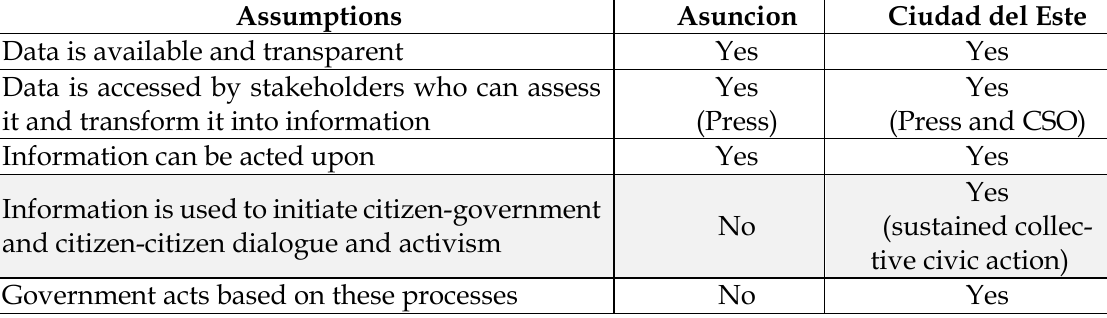
Table 5: Potential for ICT-intermediation in Asuncion and Ciudad del Este Assumptions